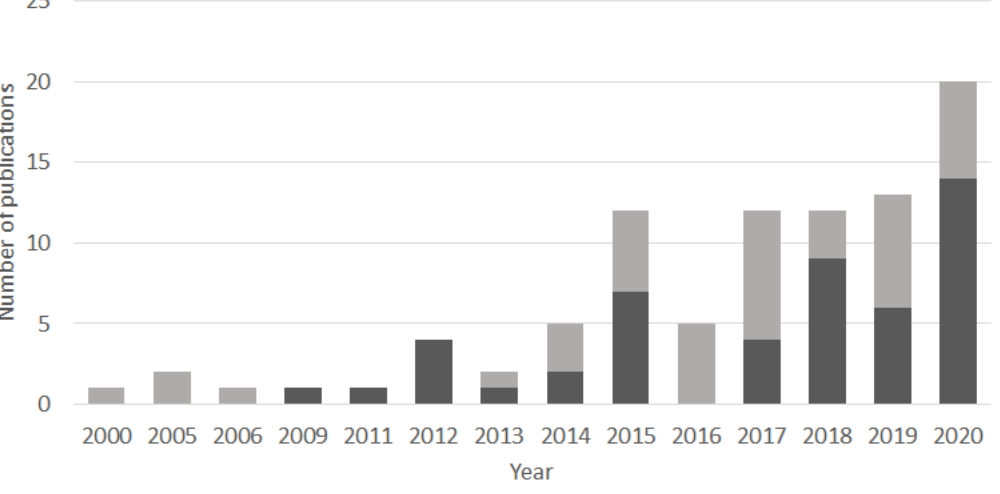
Figure 1. Bar chart showing the number of publications per year from 2000 to 2020 containing at least one of the following terms in the title, the keywords, or the abstract: sedaDNA; sedimentary ancient DNA; sedDNA; sedimentary DNA. The document search was conducted through Scopus on 25 November 2020 and was restricted to journal articles and review articles. The results are split into two categories for visualization: publications that contained the search terms sedaDNA or sedimentary ancient DNA (dark grey bars); and publications that had the search terms sedDNA or sedimentary DNA, but that did not contain the first two terms (pale grey bars).